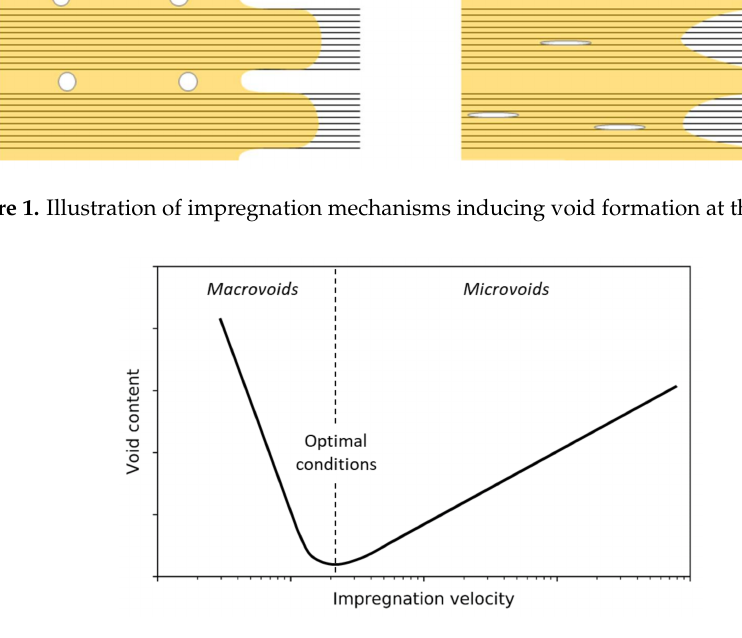
Figure 2. Influence of injection velocity on void formation during RTM